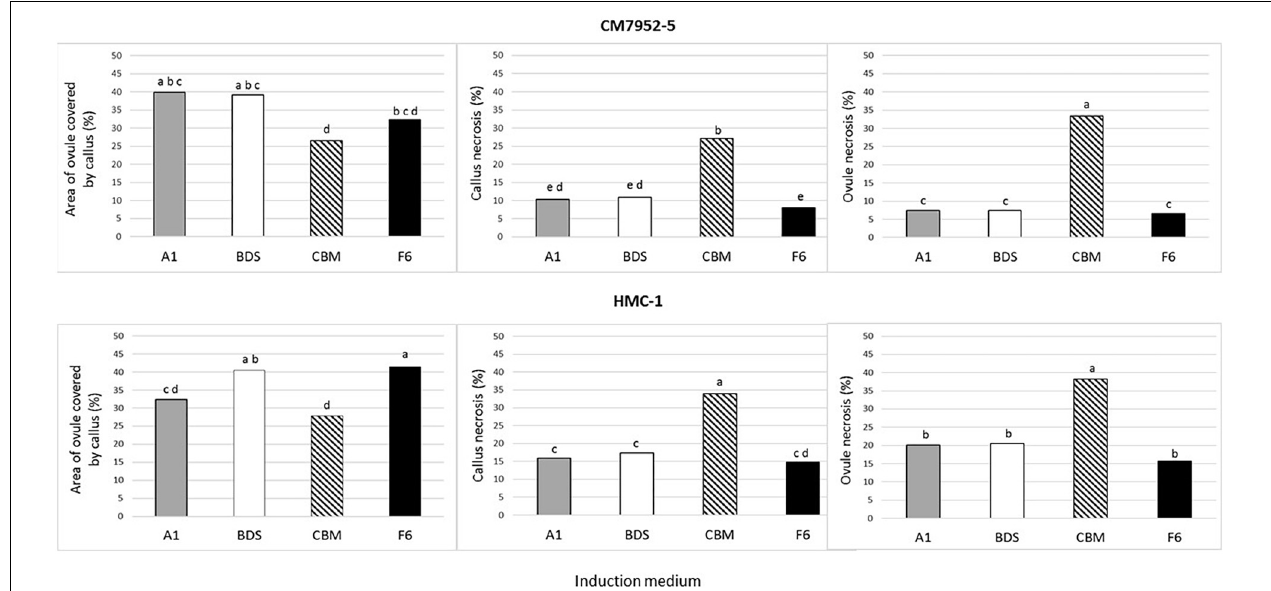
FIGURE 4 | Effect of culture medium on gynogenesis response of unpollinated isolated ovules after 4 weeks of culture using Method A and single-step induction system. The effect was measured as area of ovules covered by calli, callus necrosis, and ovule necrosis. To maximize the power of the analysis, mean values were calculated for the pooled data of 360 ovules cultured on each solid and liquid medium, for 720 data points per medium composition. The means were compared by Tukey’s Studentized Range (HSD) test. Values with identical letters indicate no significant difference at a P- value =